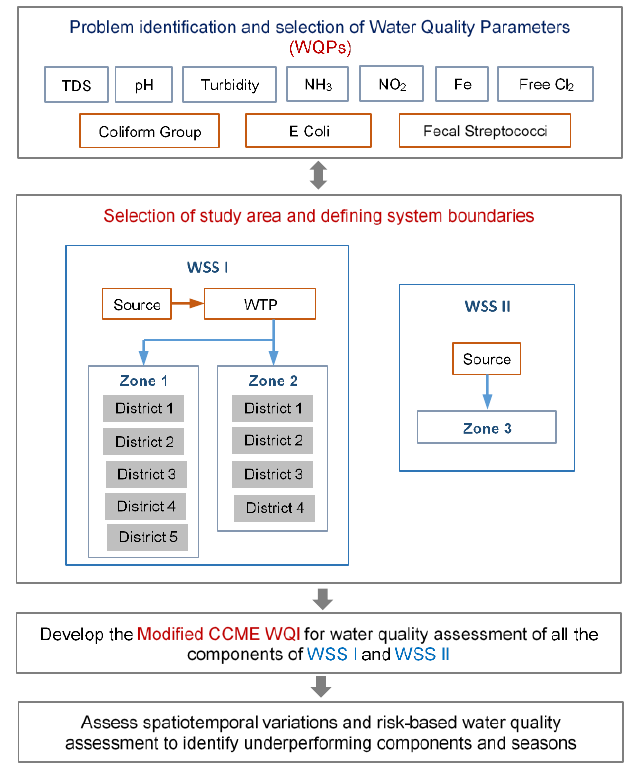
Figure 1. Proposed framework for water quality assessment of water supply systems in Qassim.